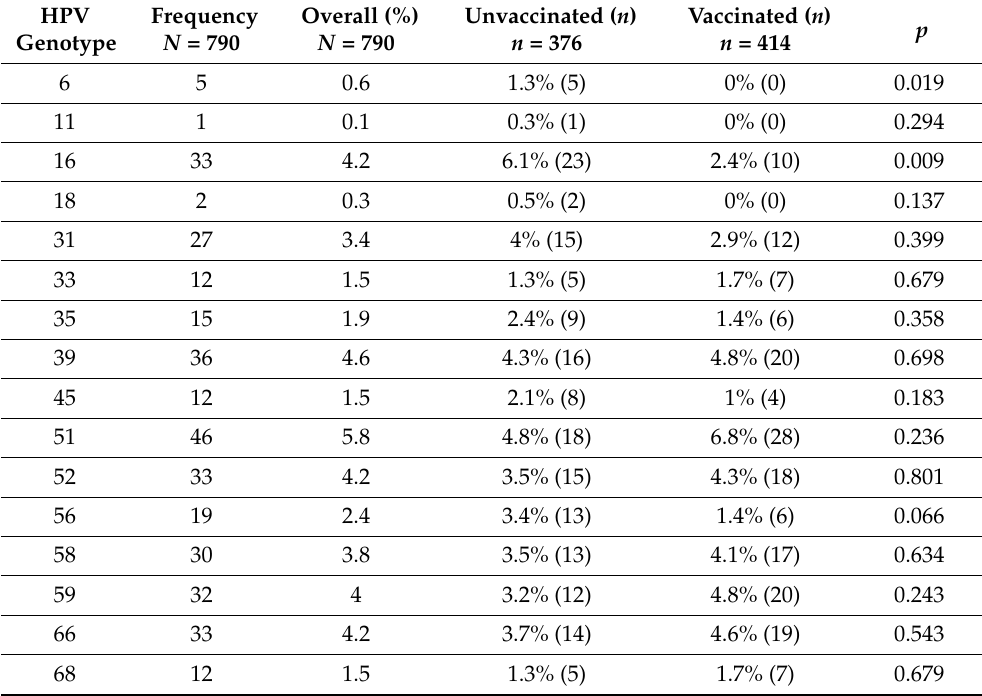
Table 4. Prevalence of HPV genotypes according to vaccination